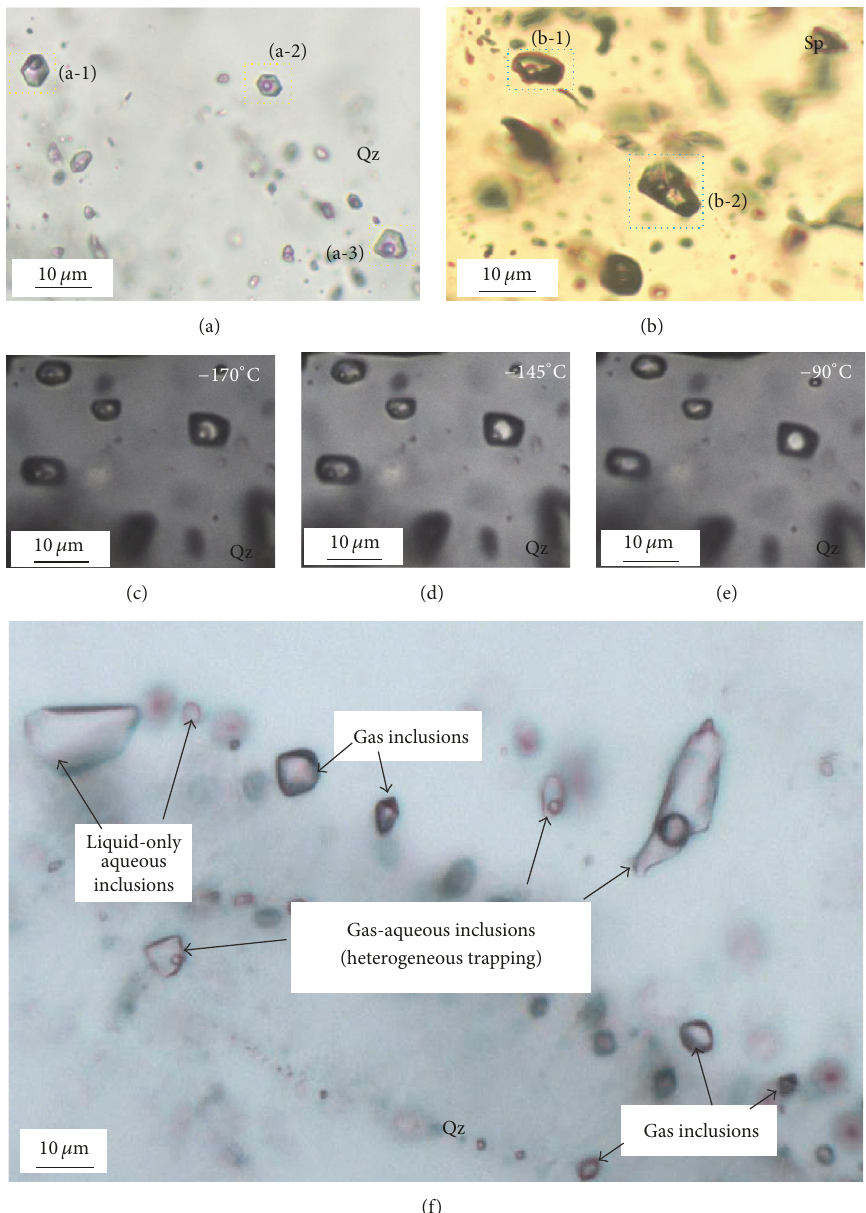
Figure 9: Photomicrographs showing fluid inclusions assemblages (FIAs) of the Nanmushu Zn-Pb deposit, under transmitted light, crossed- nicols. (a) In stage I, a trail of two-phase type I FIs (a-1, a-2, and a-3) in the quartz grain, they have consistent vapor/liquid ratios. Microthermometry measurement shows that the ranges of histograms of total homogenization temperatures ( 𝑇 h ) of this FIA are relatively small,forexample,311 ∘ Cfor(a-1),302 ∘ Cfor(a-2),and308 ∘ Cfor(a-3),respectively.Theyallhomogenizedtoliquidphase.Averagetemperature 307 ∘ C as 𝑇 h of this FIA recorded in the result. (b) In stage II, a brown grain sphalerite contains two-phase FIs (b-1 and b-2) with consistent vapor/liquid ratios and similar 𝑇 h (255 ∘ C for (b-1) and 251 ∘ C for (b-2), resp.). Both of them homogenized to liquid phase. Average temperature 253 ∘ C of this FIA recorded in the result. ((c), (d), (e)) A trail of CH 4 -rich inclusions in quartz. When the temperature decreases to − 190 ∘ C, mostofone-phaseCH 4 -richinclusionswerefrozen.Whenheatedgradually,thistypeinclusionsappearedtwo-phase((c),at − 170 ∘ C),followed by the bubbles reduced ((d), at − 145 ∘ C), and then homogenized to one liquid phase ((e), − 90 ∘ C). (f) Coexistence of gas, gas-aqueous, and liquid-only inclusions in quartz indicating immiscibility and heterogeneous trapping; Qz, quartz; Sp,